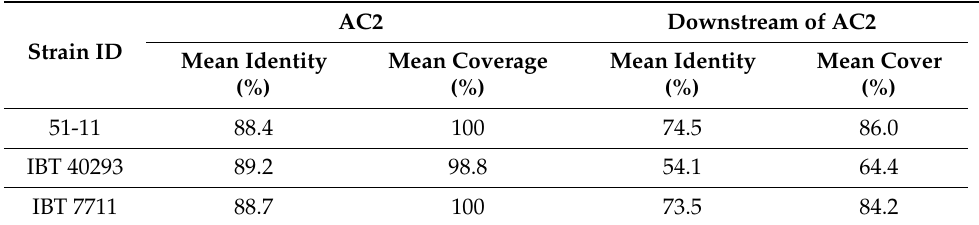
Table 6. Comparison of the presumed coding sequences of the atranone cluster 2 (AC2) and the respective scaffolds ((IBT 40288: scaffold 123); 51-11: scaffold 4, 5, and 2; IBT 40293: scaffolds 1203, 1206, and 386; IBT 7711: scaffolds 1035, 142, 1199, and 500) (compare Figure 6).